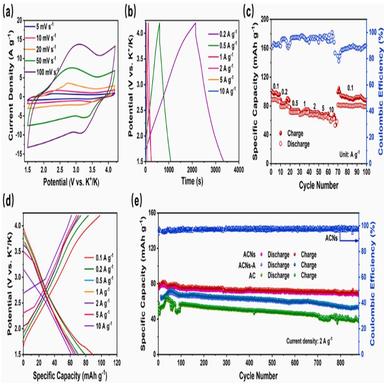
The electrochemical performance of ACNs cathode: a) CV curves at different scan rates, b) charge/discharge curves examined at various current density from 0.2 to 10 A g− 1 , c) rate capability, and d) GCD profiles at different current densities. e) Long-term cycling properties of ACNs, ACNs-A and commercial activated carbon (AC) at 2 A g− 1 . (A colour version of this figure can be viewed online.)